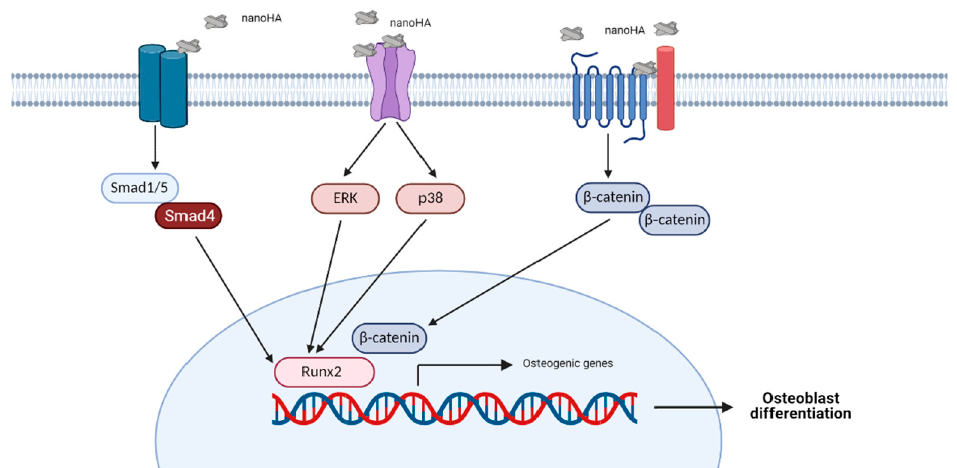
Figure 1. Potential mechanism of the HA-induced signaling pathway. The HA crystals may act as ligands which activate particular signaling receptors and increase the expression of osteogenic transcription factors, indicating osteogenic differentiation.